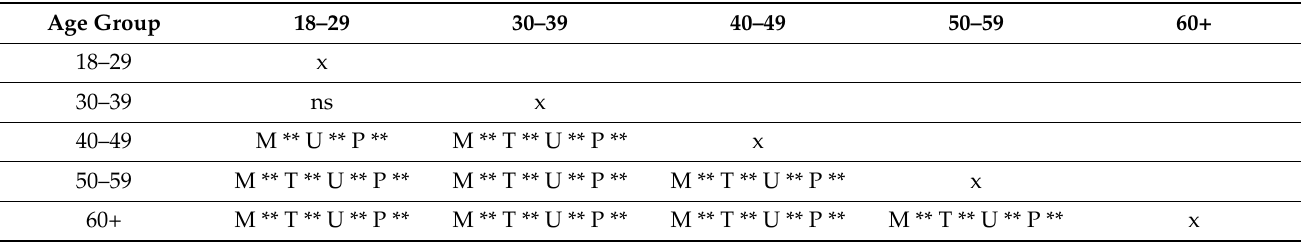
Table 6. Post-hoc results for the intention to use scores by age group and